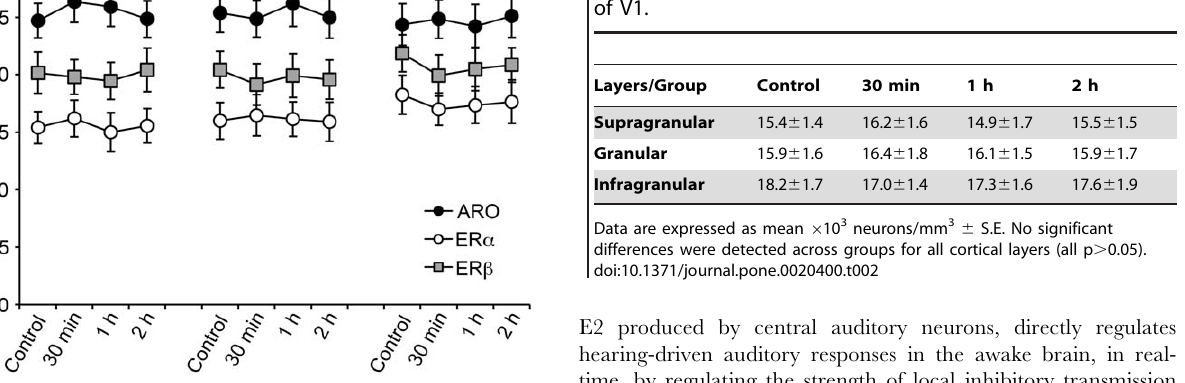
Table 2. Acute sensory stimulation does not affect the numerical densities of ER a -positive cells across cortical layers of V1.